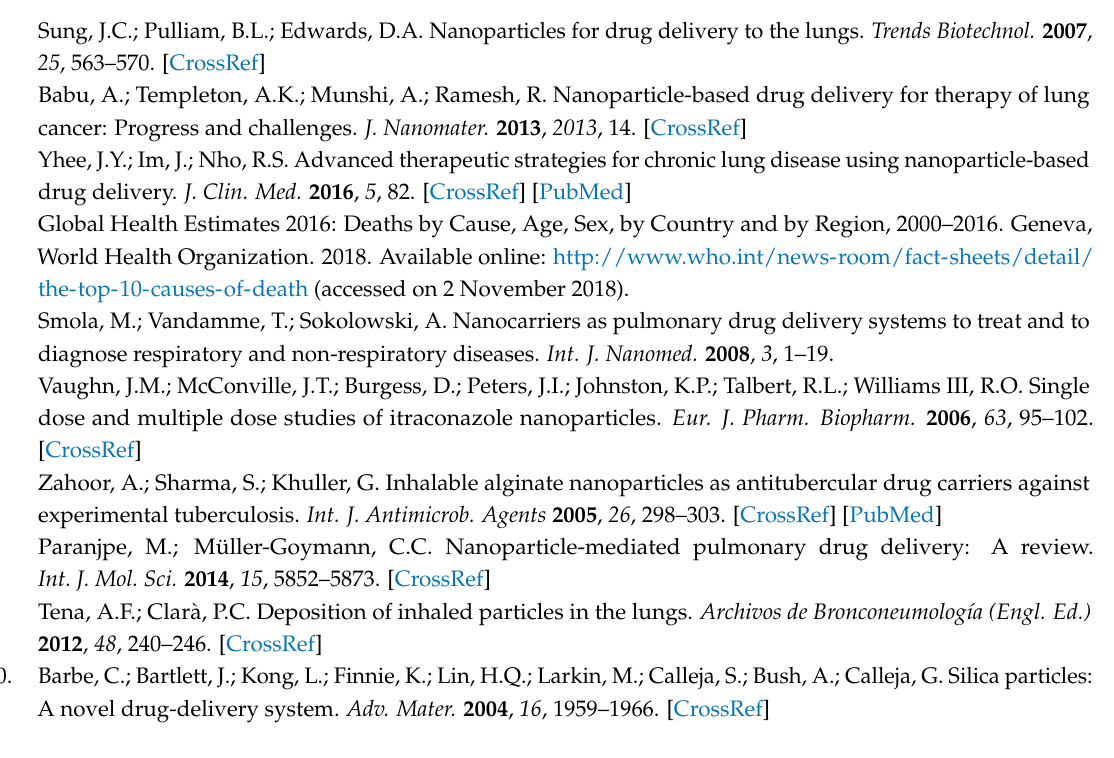
Figure S1. Five different extraction methods for removing the hexadecylamine surfactant template were compared; Figure S2. The particles extracted with acidic ethanol have higher specific surface area probably due to more efficient removal of the hexadecylamine surfactant from the pore structure; Figure S3. Thermogravimetric measurements confirm that residues of the surfactant were most likely still present in the pores after extraction with isopropanol; Figure S4. Release of dexamethasone from the silica particles coated with PEG-PEI